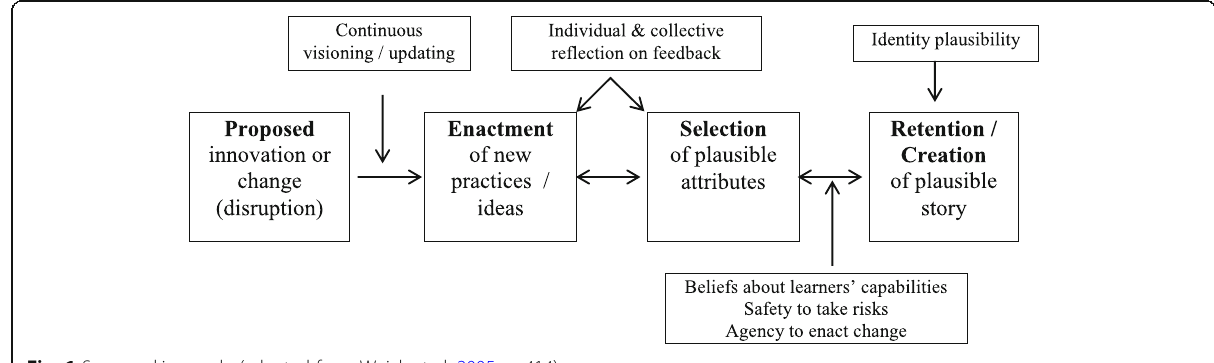
Fig. 1 Sensemaking cycle (adapted from Weick et al. 2005, p.